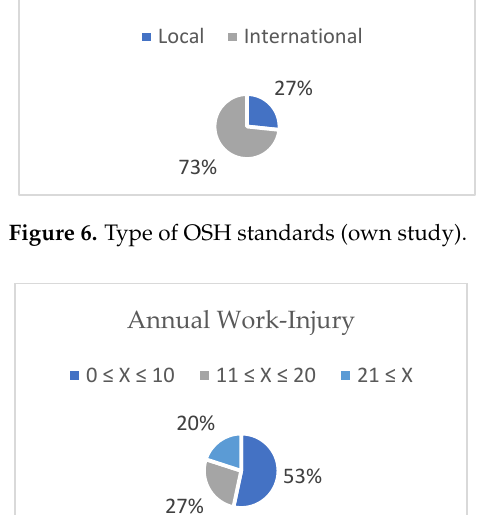
Figure 7. Annual injuries (own study).